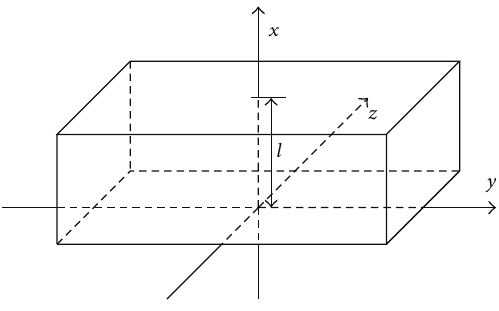
Figure 1: 3D rectangular solid